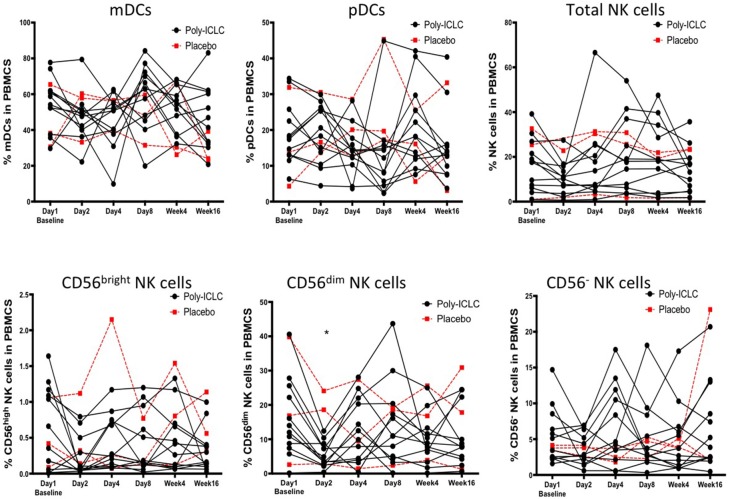
No changes in DC and NK cell numbers and activation following Poly-ICLC treatment. DC and NK cell subsets were enumerated as described following Poly-ICLC vs. placebo. Percentage of mDCs, pDCs, total NK cells, CD56 bright, CD56 dim, and CD56 negative cells in PBMCs for each subject are shown over the course of the study as measured by flowcytometry. Values for subjects in Arm A (Poly-ICLC) and Arm B (Placebo) are depicted by solid and dashed lines, respectively. Though multiple NK cell subsets declined following Poly-ICLC, the only CD56 dim NK cells were found to be statistically significant. (*p < 0.05, FDR <1).